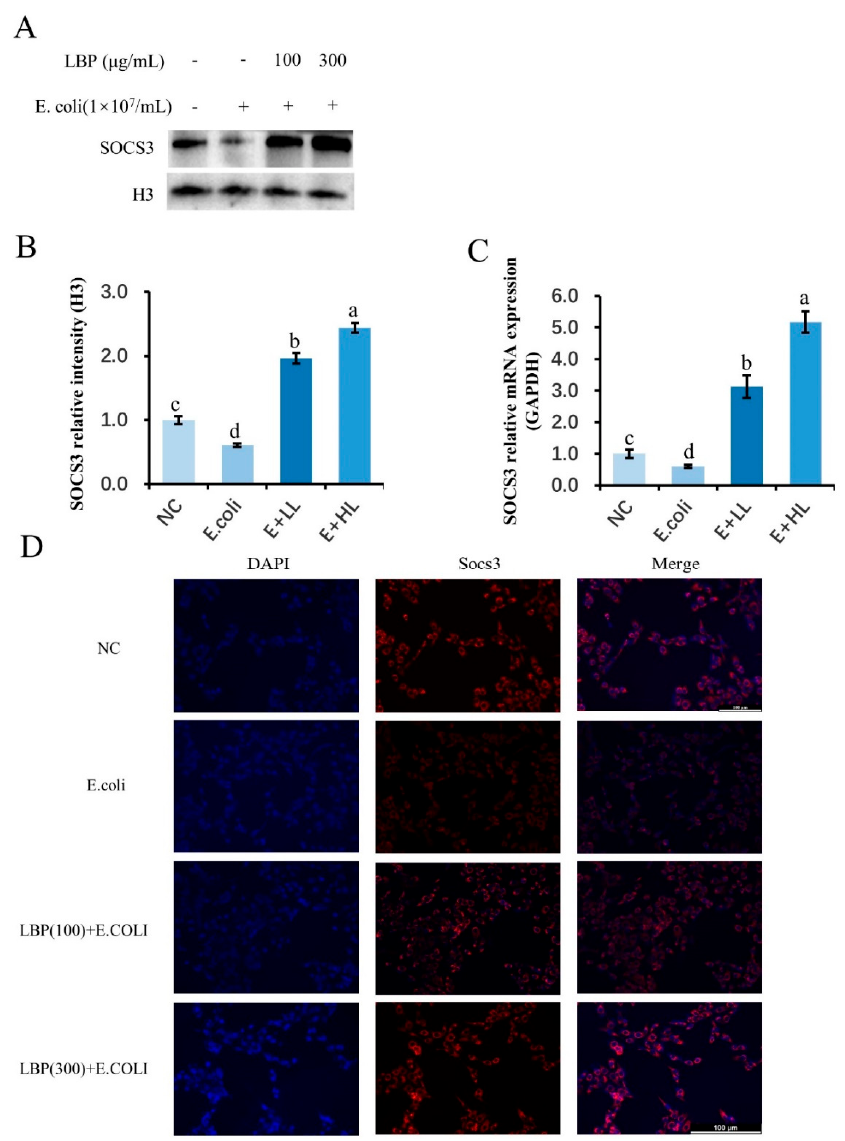
Figure 4. Effects of LBP on SOCS3 protein expression. pbMEC were treated with different doses of LBP at 100 μ g/mL or 300 μ g/mL followed by a challenge with 1 × 10 7 /mL E. coli for an additional 6 h. ( A ) Western blot analyses of SOCS3. ( B ) Relative protein abundance of SOCS3 to Histone H3. ( C ) Relative mRNA expression level of SOCS3. ( D ) Fluorescence for detecting SOCS3 abundance. Anti- bodies against SOCS3 (Cy3 labeled secondary antibody, red) and counterstained with DAPI (blue) were conducted for target protein and nuclear staining respectively. The biological replicates for PCR running were triplicate, along with triple unique experiments. Results are presented as means ± SEM. Superscripts represent that the difference between groups was significant according to sta- tistical analysis ( p < 0.05).